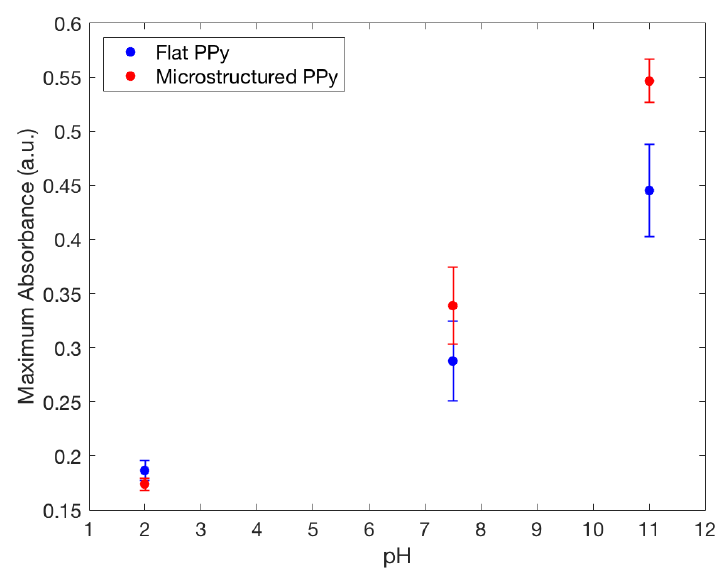
Figure 7. Maximum fluorescence spectra of fluorescein released from flat and microstructured PPy film in: TrisHCl buffer solution with pH 7.5, 0.1 mol NaOH solution with pH 11.0 and 0.1 mol HCl solution with pH 2.0, showing the increased doping capacity of microstructured films compared to